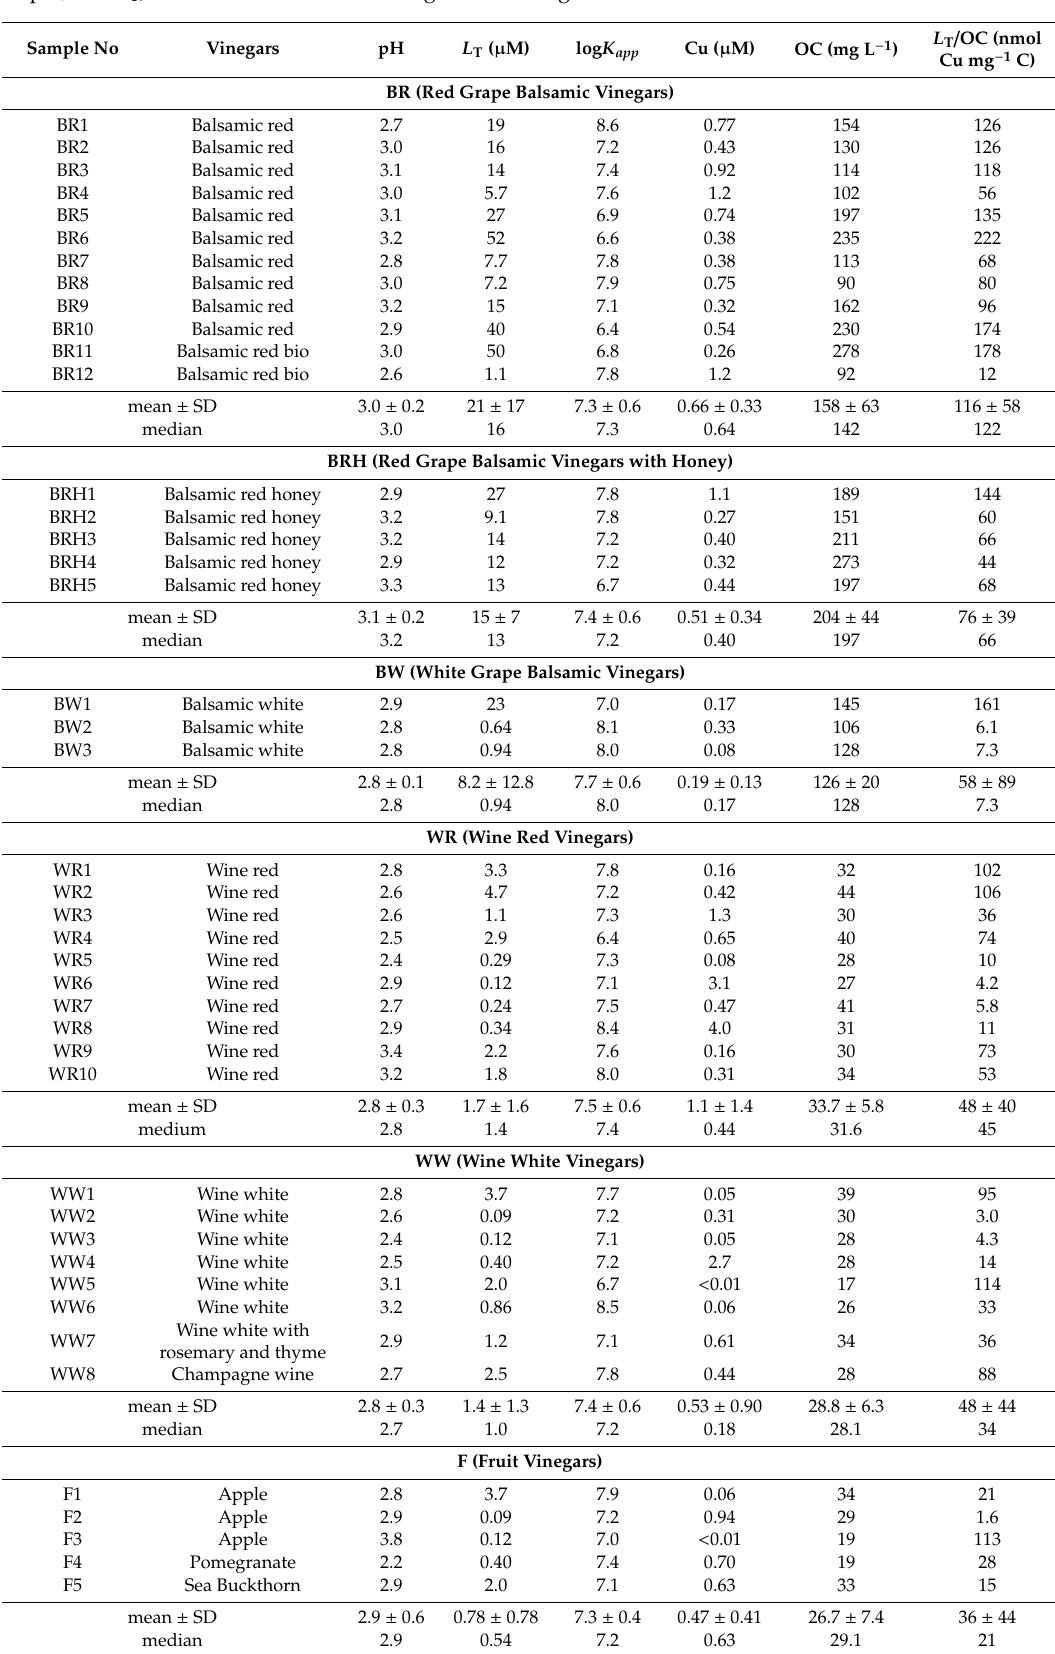
Table 1. Copper complexation parameters ( L T , log K app ), total Cu concentration, organic carbon content, pH, and L T / TOC values in di ff erent categories of